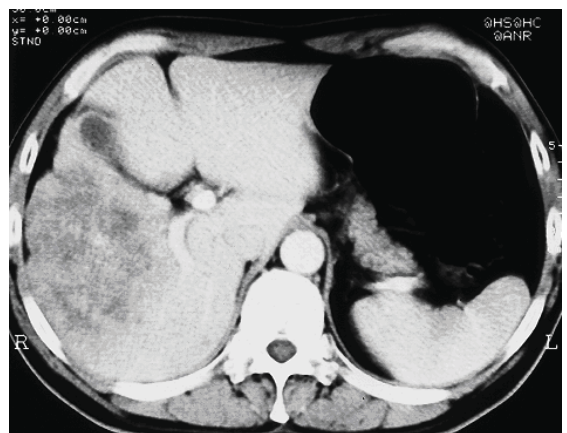
Figure 2. Histology of the resected tumor (original magnification x400) revealed squamous cell cancer with marked EGFR